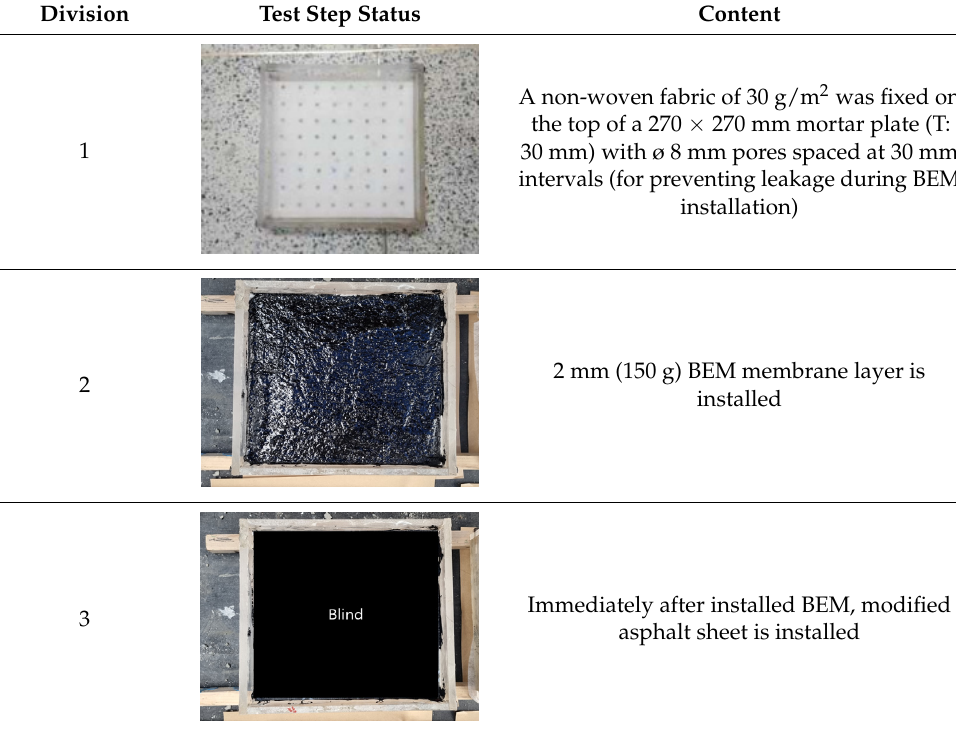
Table 5. Oil leakage stability test specimen fabrication and test method.